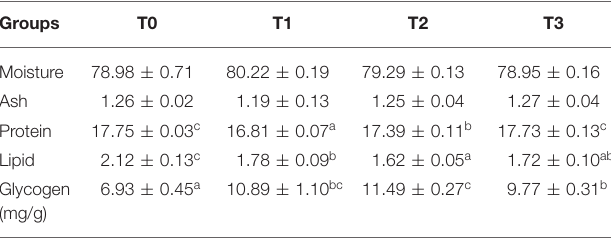
TABLE 4 | Muscle composition (%) of grass carp (means ± SD, n = 4). TABLE 5 | Amino acid content in the muscle (% dry matter) of grass carp (means ± SD, n =